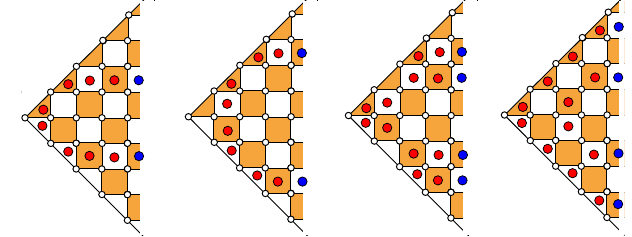
FIG. 18. Some examples of boundary and bulk configurations for the standard layout of the surface code with three-qubit checks on the boundary for the trivial coset f 0 ¼ I . The lineons travel in straight lines through the four-qubit bulk checks, but the three- qubit boundary checks have the effect of reflecting them by 90°, such that they emerge on the right boundary on the exact opposite side. Therefore, each boundary variable is perfectly correlated with the boundary variable on the exact opposite side. Separate lineons can also cross paths, resulting in a cancellation of the bulk variables. Also, for neighboring pairs of lineons, Y on the qubits shared between them cancel. These all result in correlations between the boundary variables and, therefore, entanglement in the boundary